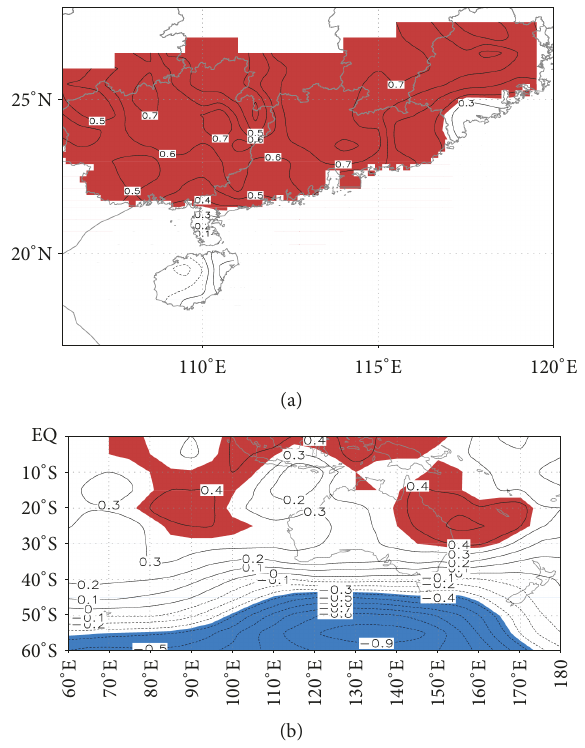
Figure 4: Correlations of the first SVD mode of the PSCPRS (a) and SLP (b). Significant values exceeding the 99% confidence level ( 𝑡 -test) are